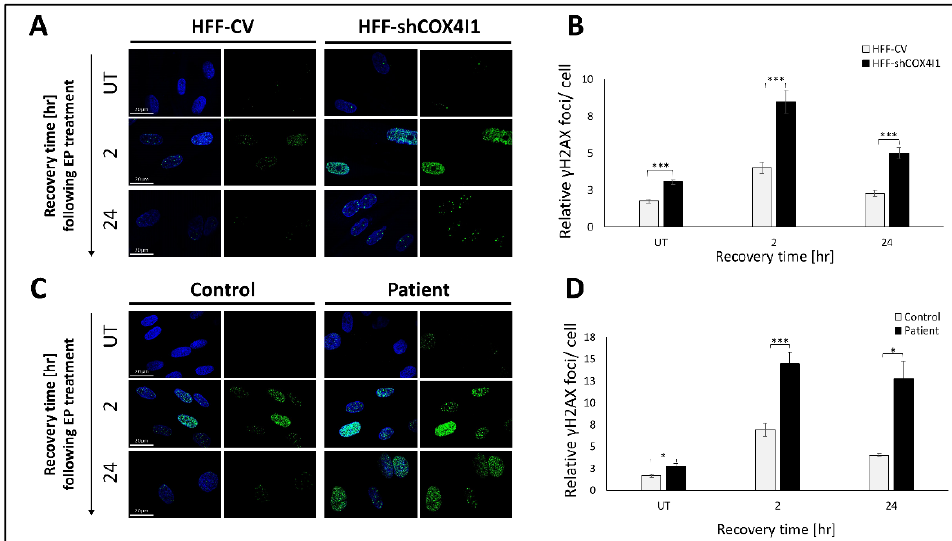
(meaning untreated cells) ± SEM of at least 100 nuclei, *p<0.05, *** p < 0.001. The results suggest that both COX4I1-deficient cells showed impaired ability to respond and thereby to recover from DNA damage, while the controls exhibited an almost complete recovery 24 h after the exposure.